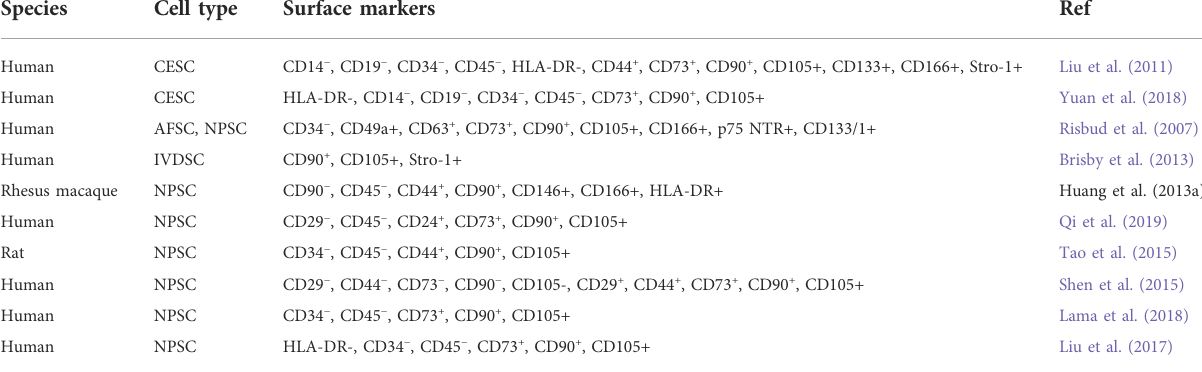
TABLE 1 Surface markers of IVD progenitor cells.